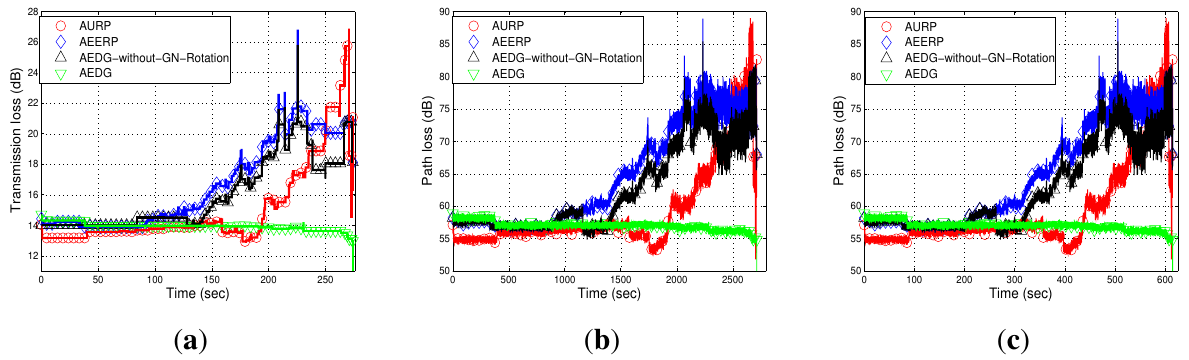
Figure 11. Path loss. ( a ) 10 nodes deployed in 100 m × 100 m; ( b ) 100 nodes deployed in 100 m × 100 m; ( c ) 100 nodes deployed in 10 km × 10